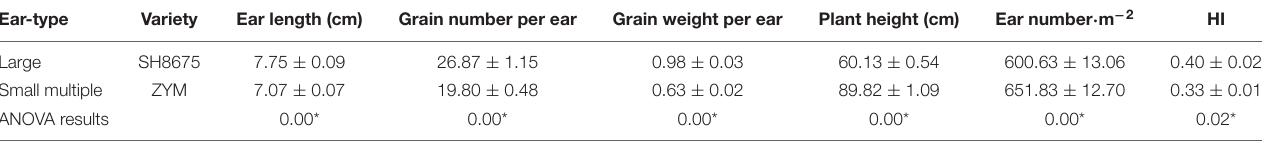
TABLE 1 | Ear traits and the ratio of harvest index of SH8675 and ZYM wheat varieties. Ear-type